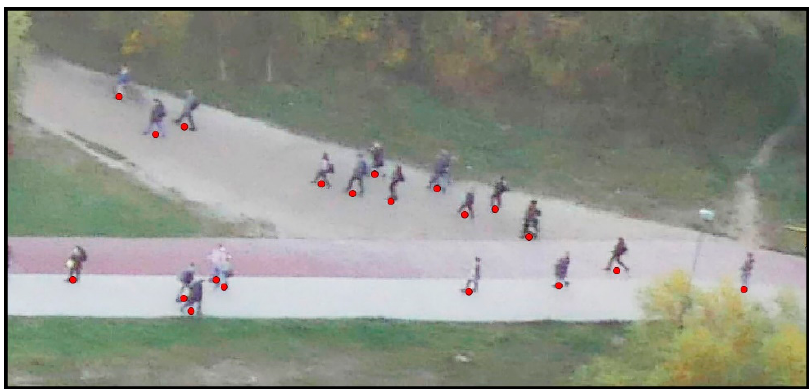
Figure 4. Vectorization of pedestrians from the research area.